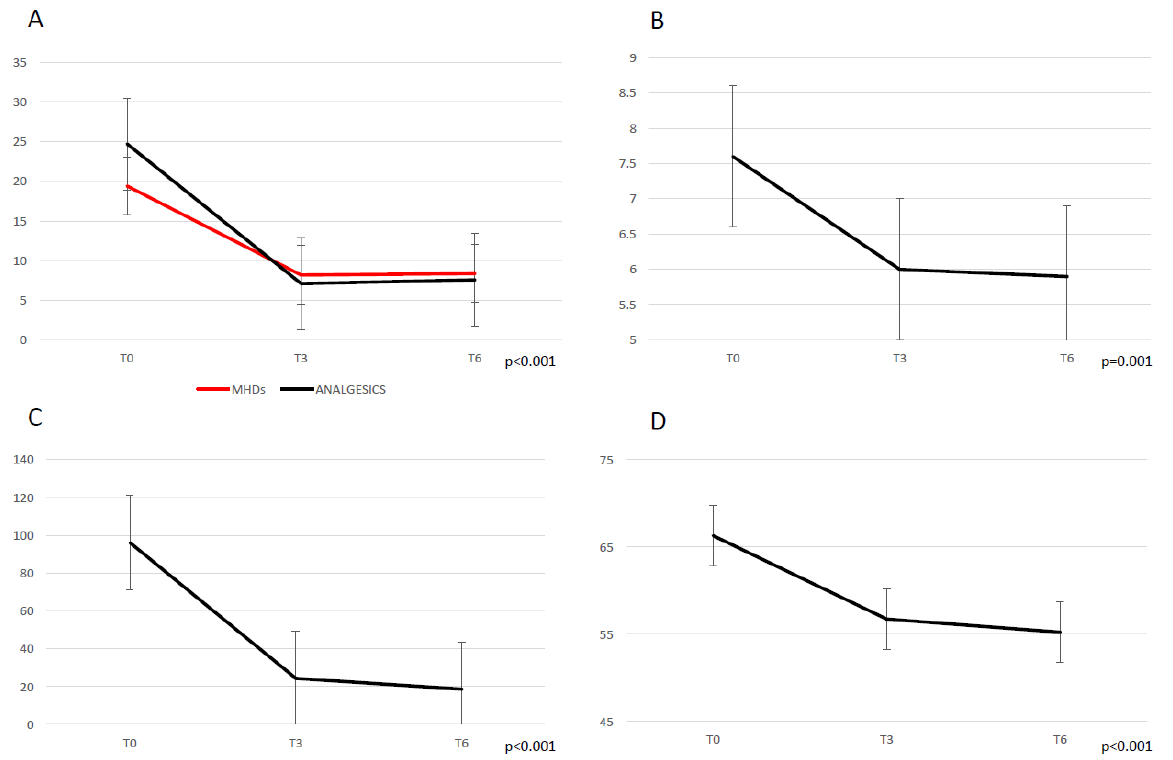
Figure 1. Migraine outcome during treatment with galcanezumab, following 3 (T3) and 6 (T6) months. ( A ) monthly headache days (MHDs) and analgesics consumption. ( B ) mean migraine attacks’ pain severity (NRS score). ( C ) MIDAS score. ( D ) HIT-6